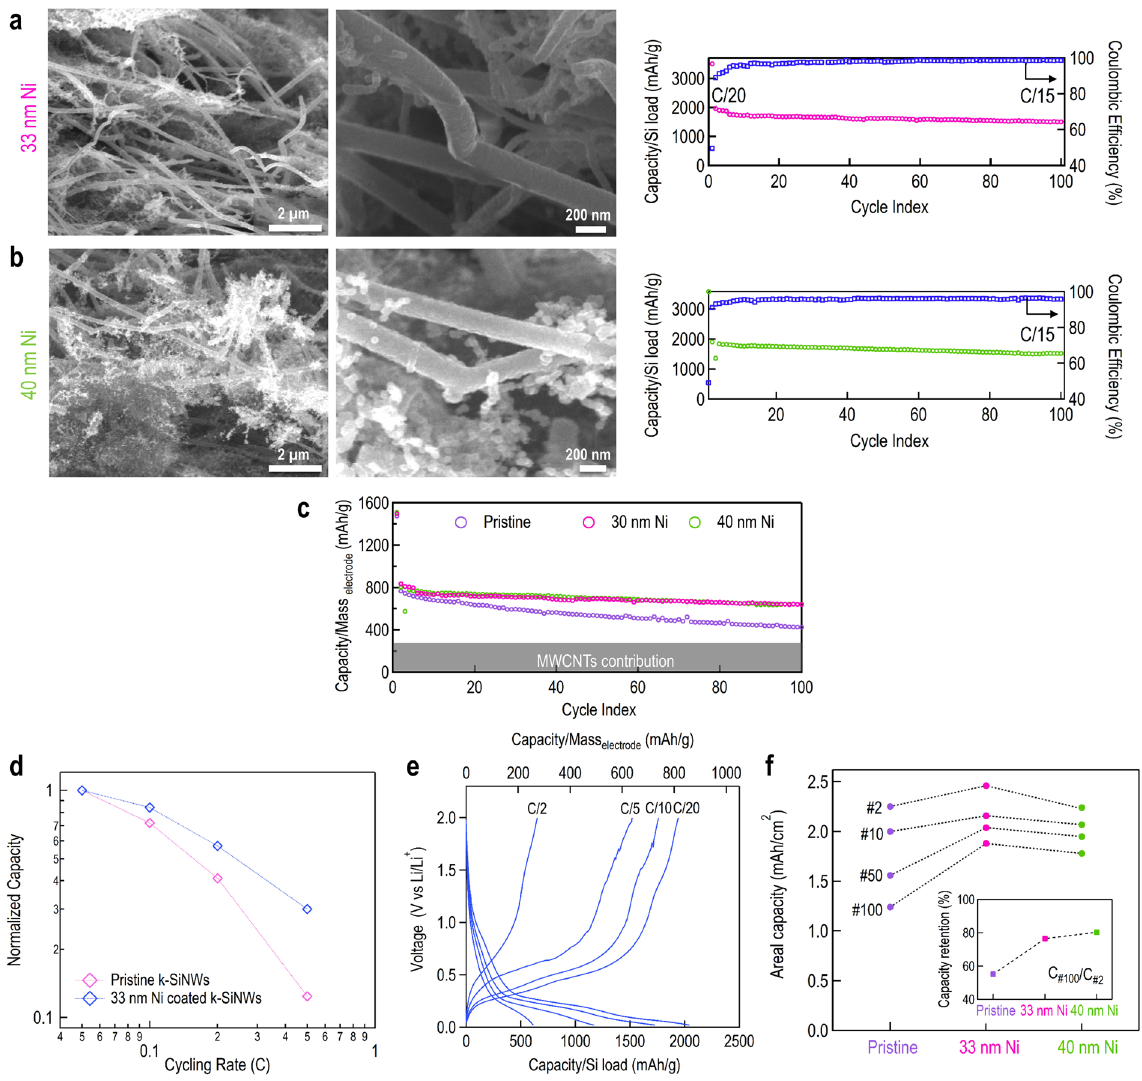
Figure 4. Electrochemical characteristics of 35% wt. k-SiNWs-based electrodes coated with Ni. ( a ) 33 and ( b ) 40 nm Ni-coated assemblies and their associated electrochemical behavior. Capacity (lithiation) normalized to the whole electrode mass (both contributions of Si and MWCNTs) ( c ). After 50 cycles, the capacity for the 40 nm Ni-coated assembly is 700 mAh/g compared to 695 mAh/g for the 33 nm Ni-coated electrode. Normalized capacity as a function of C rate for pristine and 33 nm Ni-coated assemblies with the corresponding galvanostatic charge-discharge profiles ( d ). Charge-discharge profiles according to the capacity per Si load (bottom axis) and the entire electrode load (top axis) ( e ). Areal capacity for the studied electrodes ( f ). At the displayed electrode load (1 mg Si /cm 2 ), an areal capacity of 2.4 mAh/cm 2 can be achieved. Regarding the capacity retention, both Ni-coated electrodes present similar characteristics, retaining 80% of the initial capacity (relative to cycle 2) compared to 55% for the pristine